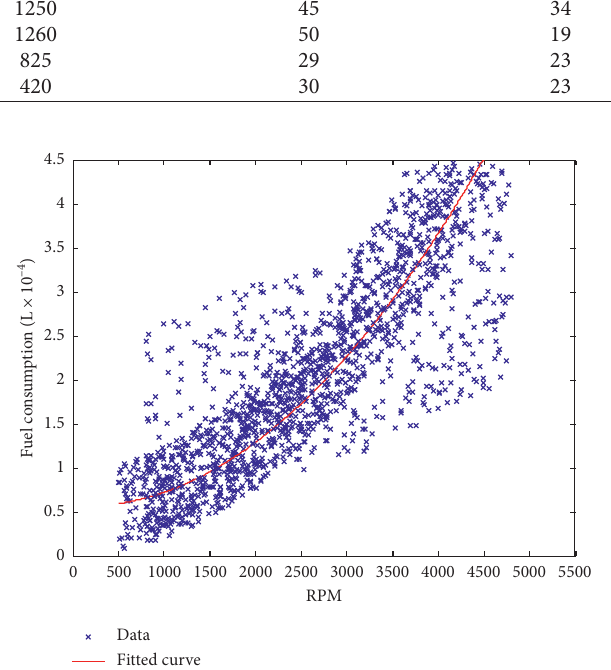
Figure 5: Fuel consumption vs.